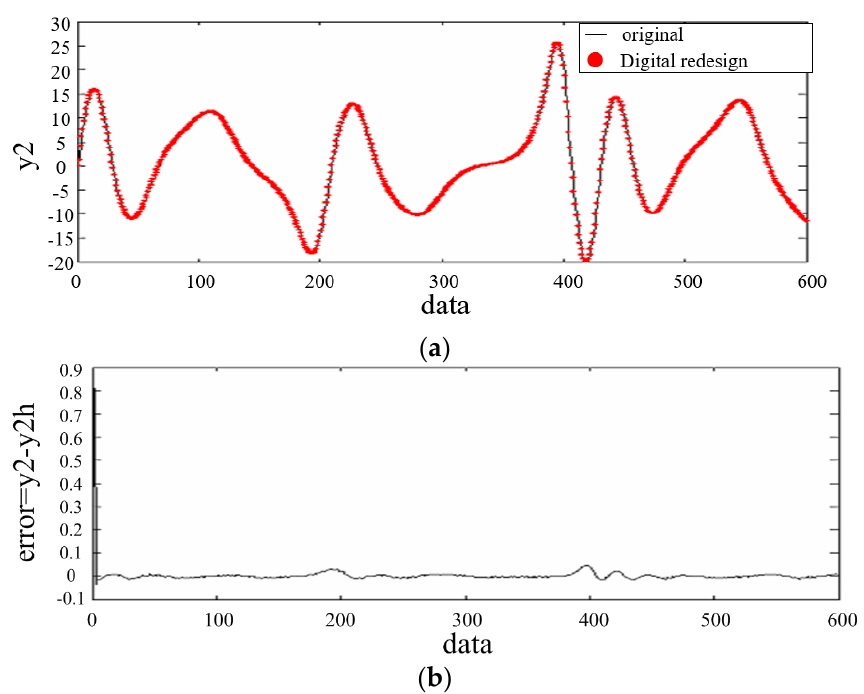
( t ) and ˆ y ( t ) ; ( b ) Data of output error (cid:101) y 1 1